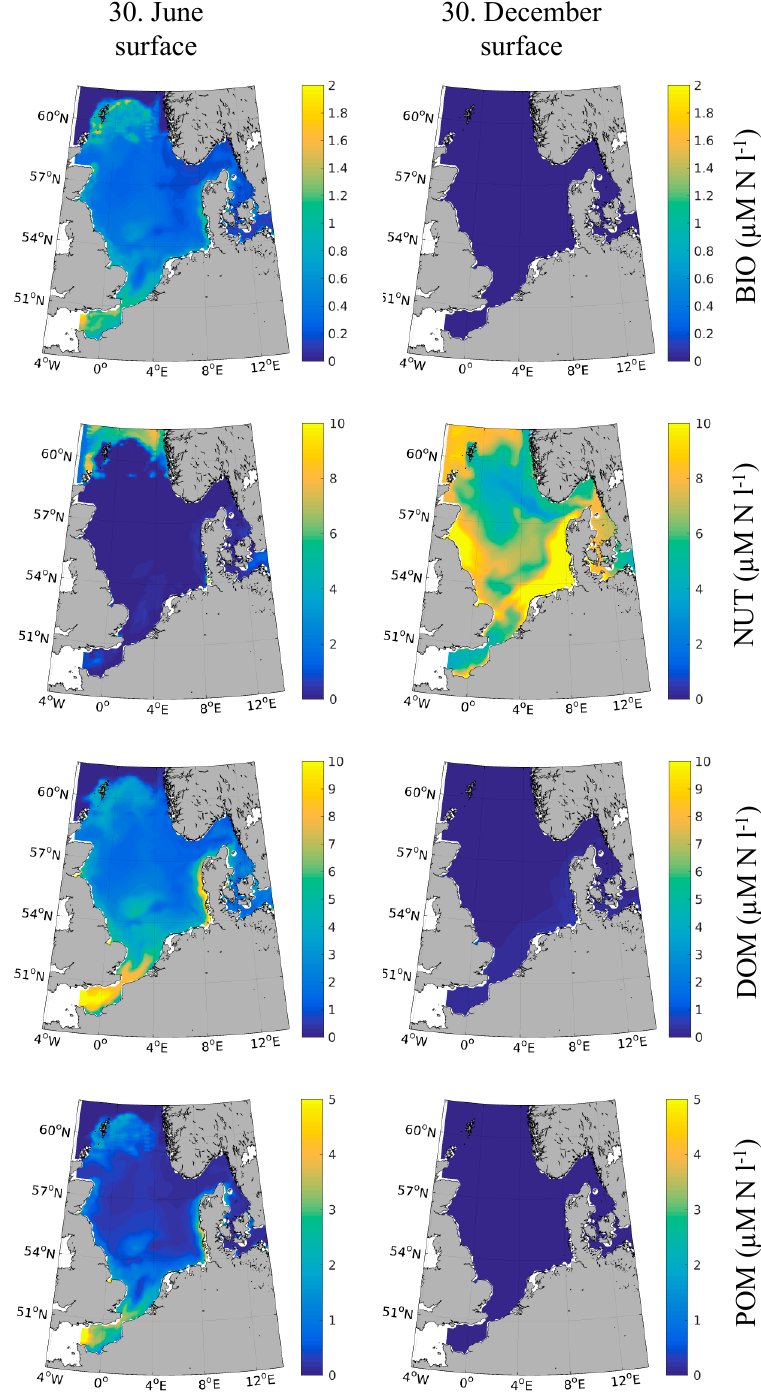
Figure 3. Surface distribution of the variables BIO, DOM, NUT (representing nitrate in the model), POM in June ( left ) and December ( right ) as estimated in the biogeochemical module OxyDep. Aiming at understanding the seasonal variability of the nitrogen species in the North Sea, Suratman et al. [53] measured the following typical ranges of the surface concentrations of nitrate (0.1–7.2 µM N), ammonium (0.1–2 µM N), DON (the dominant fraction of total nitrogen in all